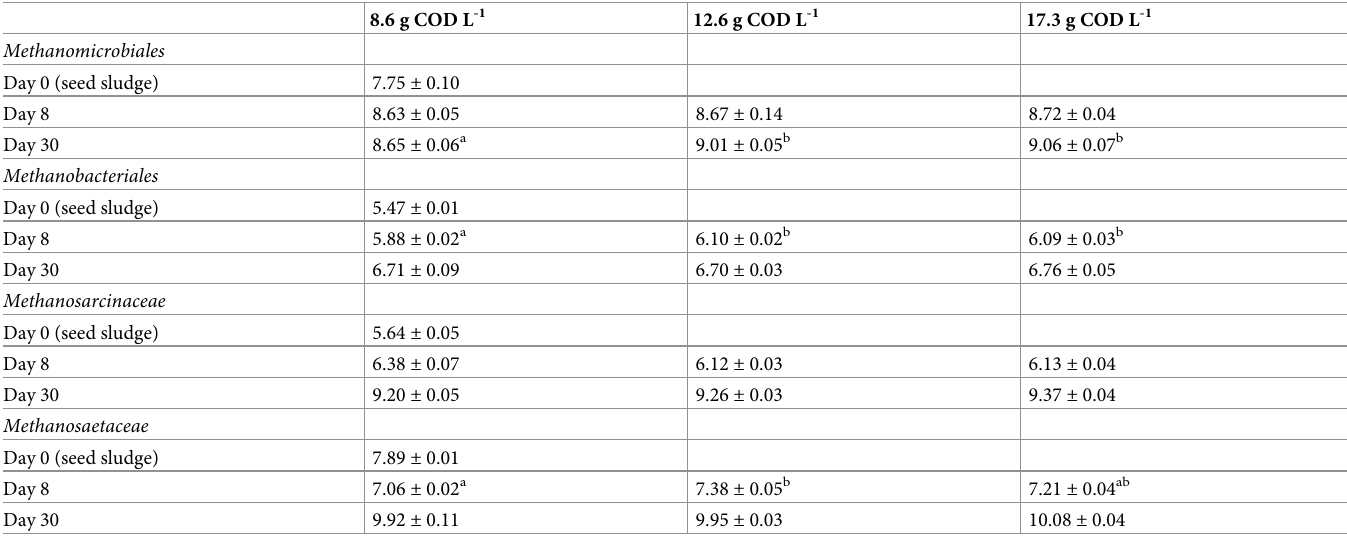
Table 2. The transition of 16S rRNA copies for acetoclastic and hydrogenotrophic methanogens (log copies mL -1